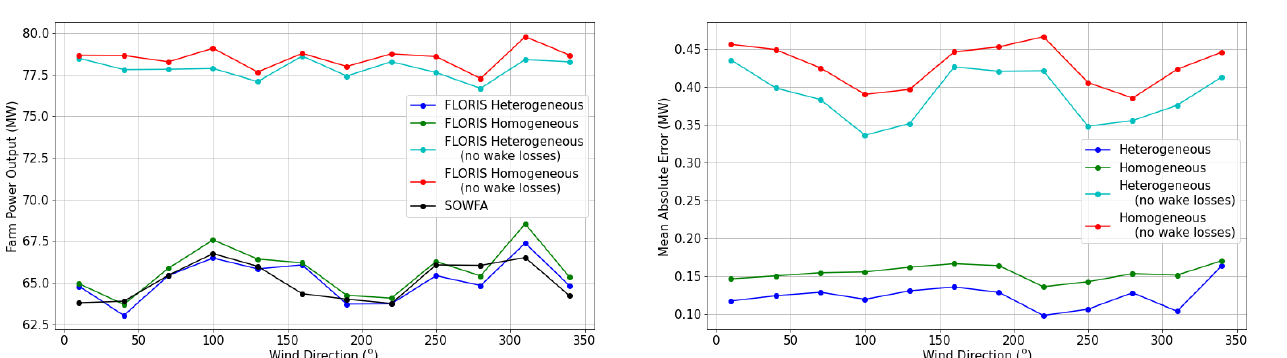
Figure 15. Mean absolute error of individual turbine power output predictions calculated using the homogeneous and heterogeneous FLORIS models, with and without wake